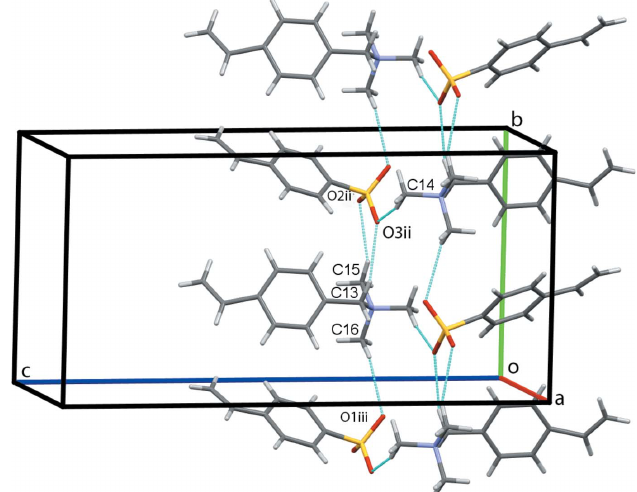
Figure 3 Double chains of cation–anion dimers along b . Hydrogen bonds are shown as cyan dotted lines [symmetry codes: (ii) 1 (cid:3) x , 1 (cid:3) z ]. 1 (cid:3) x , (cid:3) 1 + y , 1 2 2